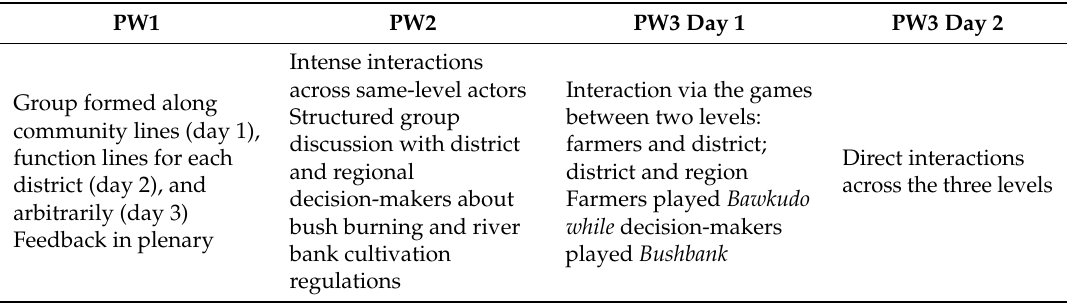
Table 3. Structure of participation. PW1: participatory workshop 1; PW2: participatory workshop 2; PW3: participatory workshop 3.